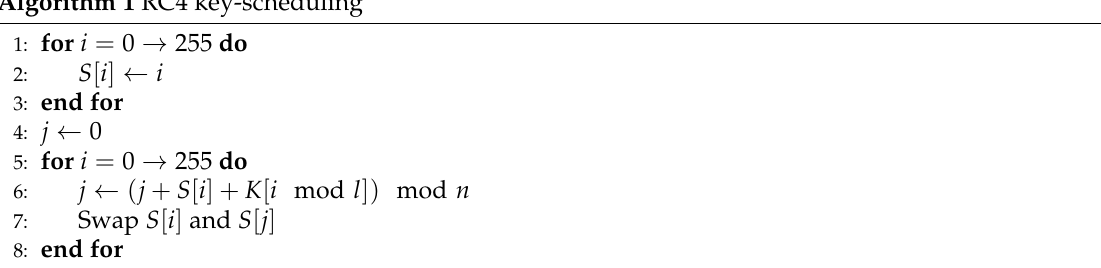
Algorithm 1 RC4 key-scheduling